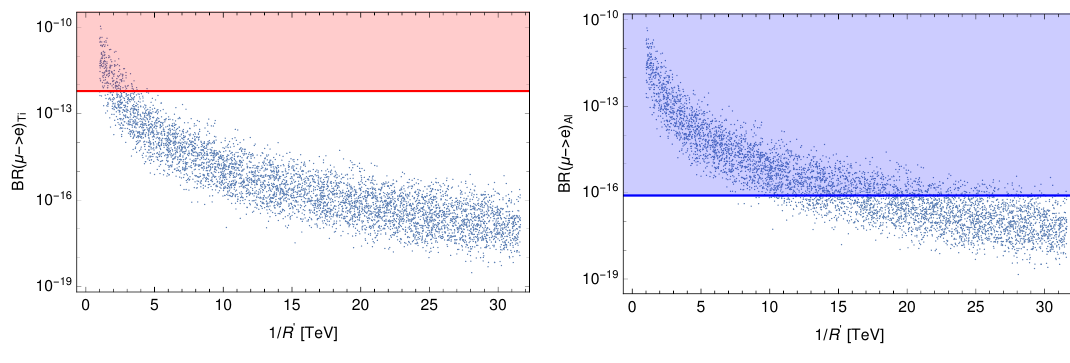
Figure 1 . Current bound on µ − e conversion in Titanium (left) and future bound on µ − e conversion in Aluminium (right), displayed together with the predictions of our scan as a function of 1 /R 0 . The points in the red (blue) region are (expected to be)